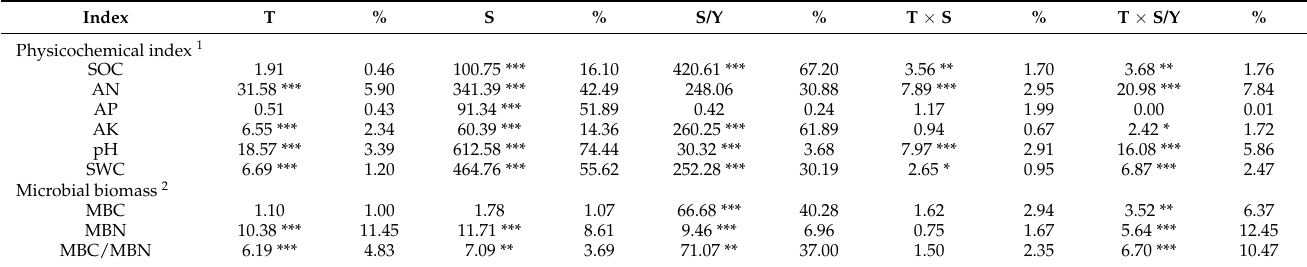
Table A1. The effect of residual treatments (T), study period (S, season; Y, year), and their interaction on the soil physicochemical index and microbial biomass, which were analyzed using repeated nested analysis.